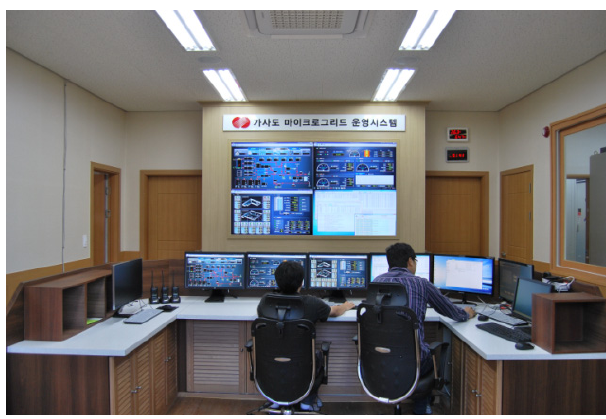
Figure 7. Energy management system.